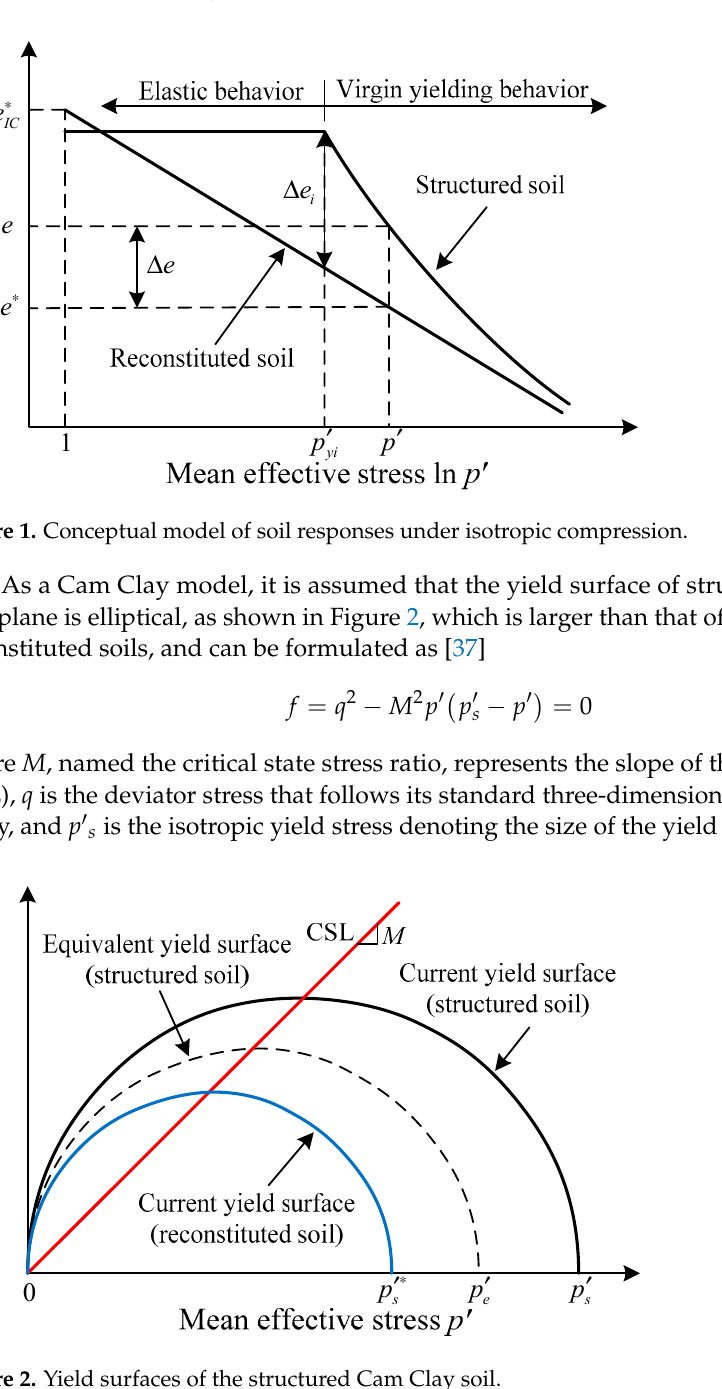
Figure 2. Yield surfaces of the structured Cam Clay